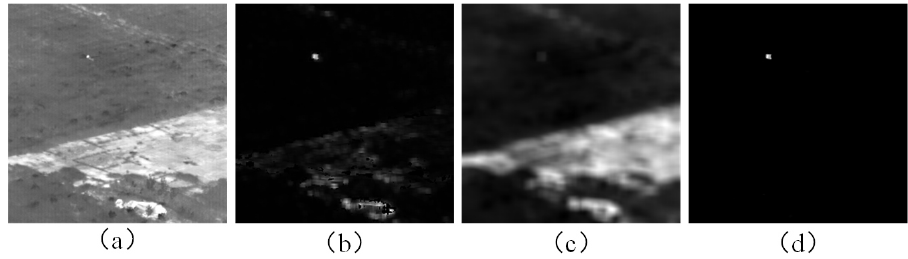
Figure 3. Small-target local priori weight. ( a ) Input image. ( b ) Gradient features. ( c ) Edge and highlighted area indicator. ( d ) Target local